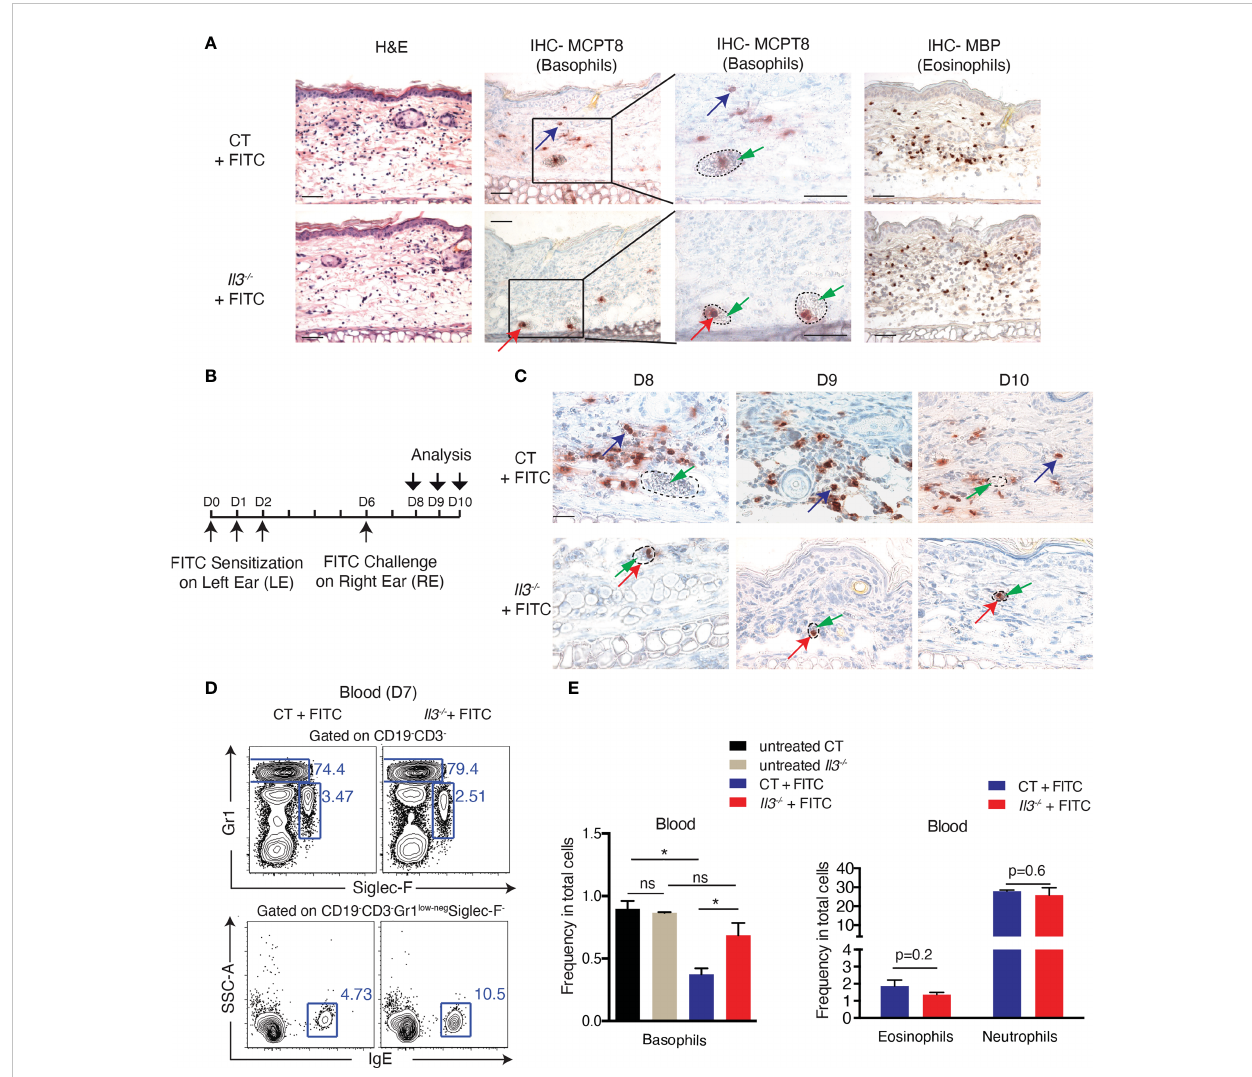
FIGURE 3 IL-3 is crucial for basophil extravasation to FITC-induced ACD skin. (A) HE and IHC staining of RE sections at D7. Red arrow points to one of basophils inside blood vessels, whereas blue arrow points to one of basophils out of blood vessels. The green arrow points to red blood cells inside the vessel. Dashed circles outline blood vessels. (B-C) Il3 -/- and CT mice were sensitized at D0, D1 and D2 on LEs and challenged at D6 on REs, which were analysed at D8, D9 and D10 (B) for Mcpt8 IHC staining (C) . Scale bar, 50 m m. (D) Representative FACS plots of blood cells for CD19 - CD3 - Gr1 - SiglecF - IgE + (basophils), CD19 - CD3 - Siglec-F + Gr1 low-neg (eosinophils), and CD19 - CD3 - Gr1 hi (neutrophils) from FITC-treated CT and Il3 -/- mice. (E) Comparison of frequency of basophils (left panel), eosinophils and neutrophils (right panel) in total cells. *P ≤ 0.05 (Student's t-test). ns, non signi fi cant. Values are mean ± SEM (n ≥ 3 mice per